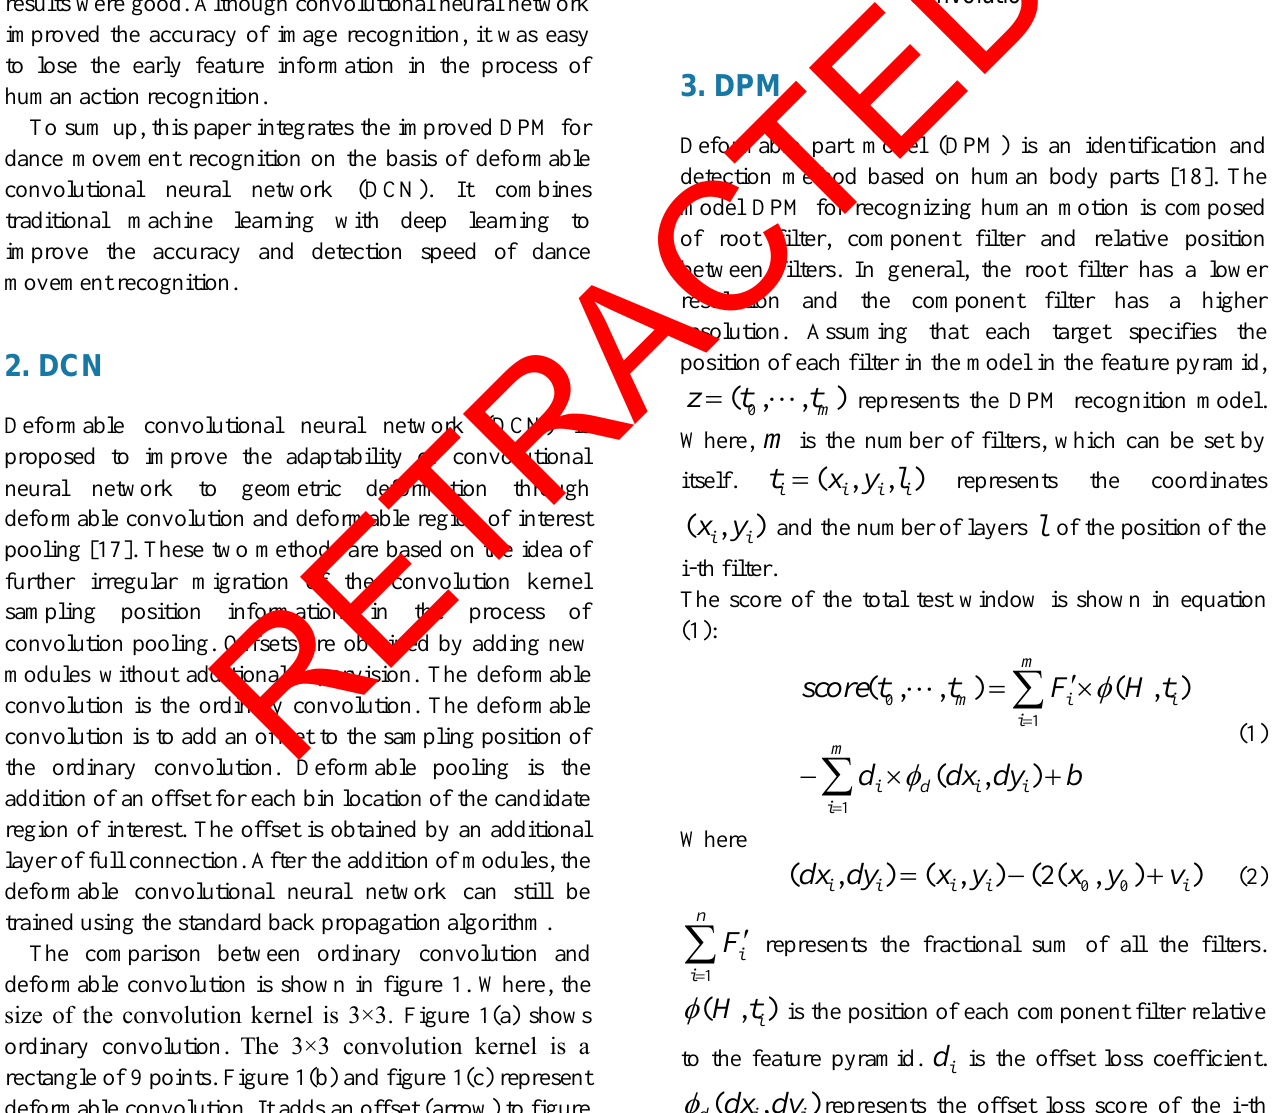
Figure 1. Traditional convolution and deformable